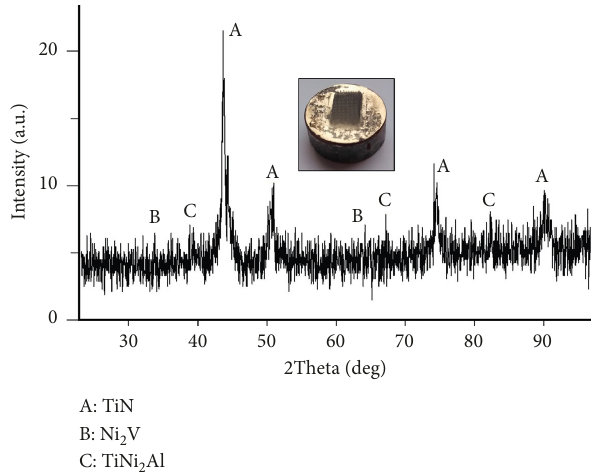
Figure 12: XRD pattern of Sample No. 4 (as example).